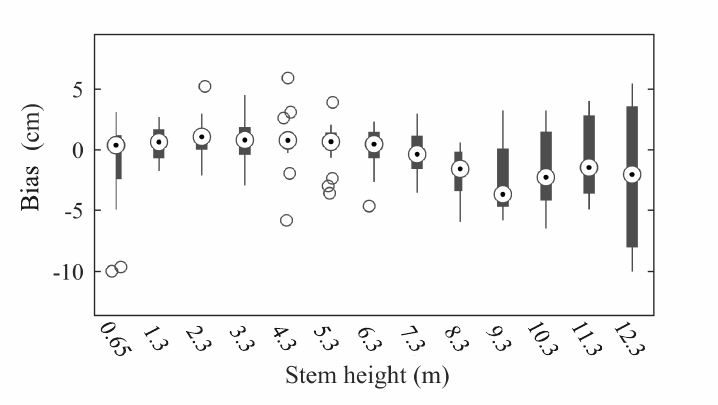
Figure 11. Bias of diameter estimation and its distribution with height. Results are evaluated from all